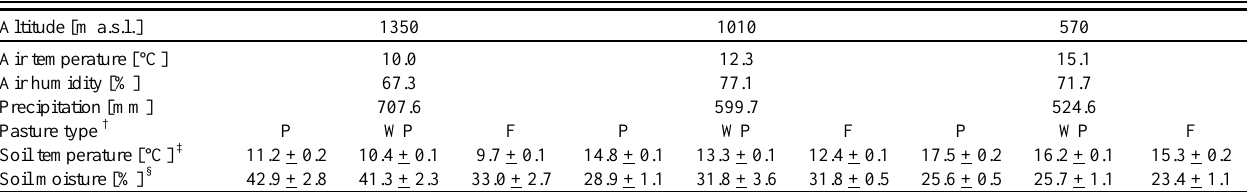
Table 2 . Microclimate data overview for the plant growing season (AMJJAS) of 2010. Presented are mean parameter values for each altitude and pasture type. Altitude [m